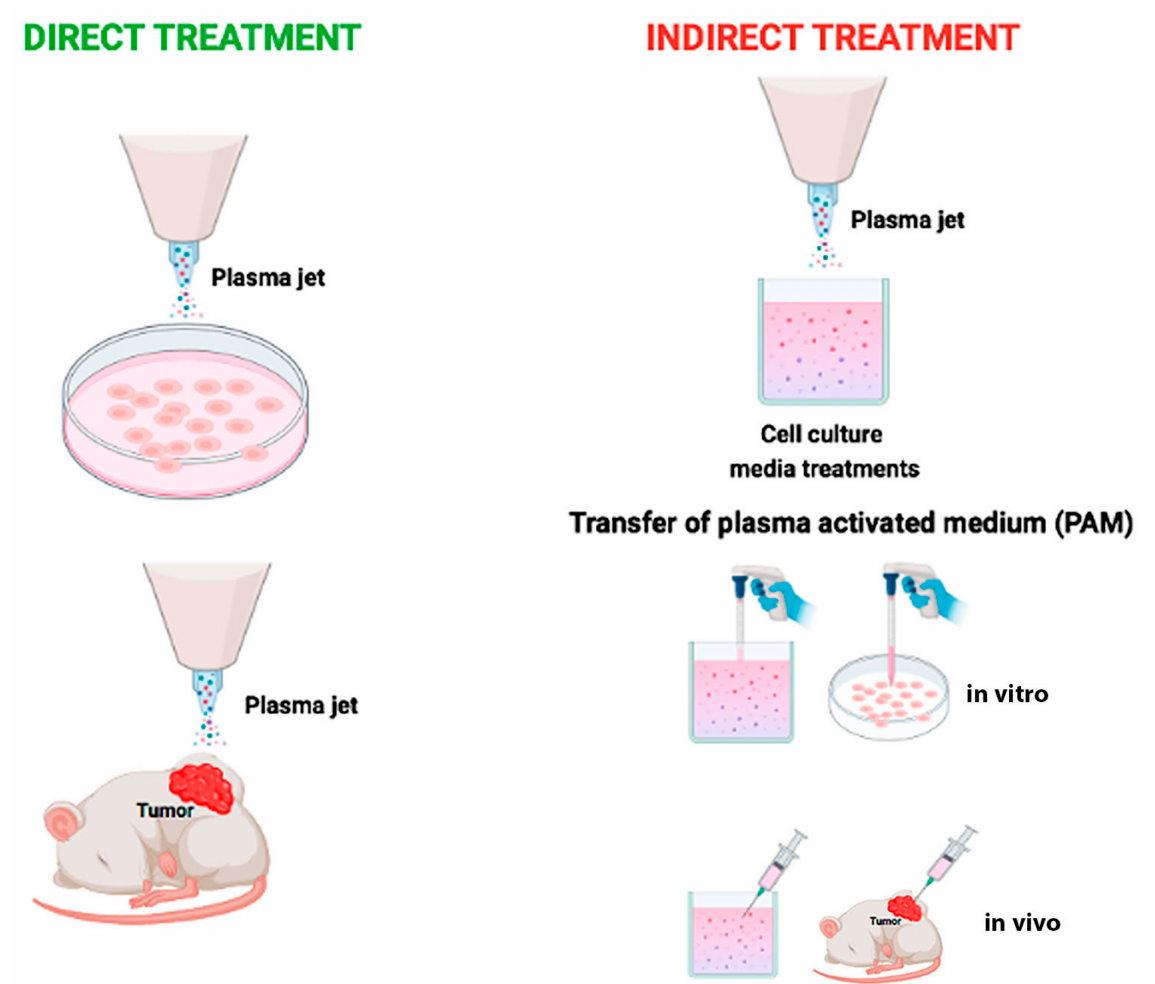
Figure 1. Schematic representation of two basic strategies to use cold atmospheric plasma. Direct cold atmospheric plasma treatment on cancer cells in vitro or on subcutaneous xenograft tumors in vivo ( left ). Indirect cold atmospheric plasma treatment on solutions, mostly medium. Plasma Activated Medium is used to treat cancer cells seeded in dish or tumor tissues in mice ( right